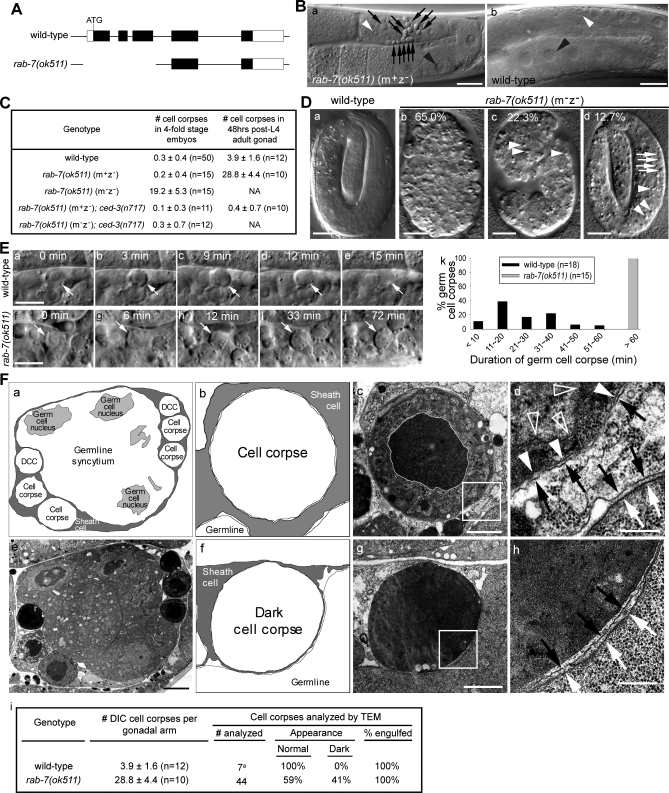

rab-7(ok511) Mutant Animals Accumulate Engulfed Cell Corpses and Are Maternal-Effect Embryonic Lethal(A) rab-7 gene structure and the deletion in rab-7(ok511) allele. The coding and noncoding regions of exons are shown as black and white boxes, respectively. The single lines between exons are introns.(B) DIC images of rab-7(ok511) (m+z−) (a) and wild-type (b) gonads in adult hermaphrodites at 48 h post-L4 stage. Anterior is to the left. Ventral is to the bottom. Arrows indicate cell corpses. White and black arrowheads indicate germ cell and oocyte nuclei, respectively. Scale bars indicate 20 μm.(C) The numbers of cell corpses. Data are presented as mean ± SD. n, number of animals scored; NA: not applicable due to embryonic-lethal phenotype.(D) DIC images of a wild-type 4-fold stage embryo (a) and rab-7(ok511) (m−z−) embryos that arrest prior to elongation (b), at 1.5-fold stage (c), and at 4-fold stage (d). rab-7(ok511) (m−z−) embryos were synchronized and were scored 12 h after being laid. The percentage of each class of phenotype is labeled. Arrows indicate cell corpses. Arrowheads indicate granules. Scale bar indicates 10 μm.(E) DIC time-lapse recording of germ-cell death induced by γ-ray irradiation and their subsequent removal in the gonad of wild-type (a–e) and rab-7(ok511) (f–j) adult hermaphrodites. Scale bar indicate 5 μm. (k) Histogram indicating distribution of the durations of germ-cell corpses. n, number of cell corpses scored. Two animals were used for each genotype.(F) TEM images of a rab-7(ok511) (m+z−) gonad. (e), (c), and (g) Indicate a cross section (e) and its enlarged regions that contain germ-cell corpses (c) and (g). Traces of membranes corresponding to (e), (c) and (g) are shown in (a), (b) and (f), respectively. Further enlarged images of framed regions in (c) and (g) are shown in (d) and (h), respectively. White arrows indicate germ-cell membrane; black arrows indicate sheath cell membrane; white arrowheads indicate cell corpse membrane; white open arrowheads indicate the nuclear envelope of the cell corpse. Scale bars indicate 5 μm in (e); 1 μm in (c) and (g); and 250 nm in (d) and (h). DCC, dark cell corpse. (i) Percentages of engulfed cell corpses in the gonads of wild-type and rab-7(ok511) at 48 h post-L4. A superscript letter a (a) indicates data from [1].